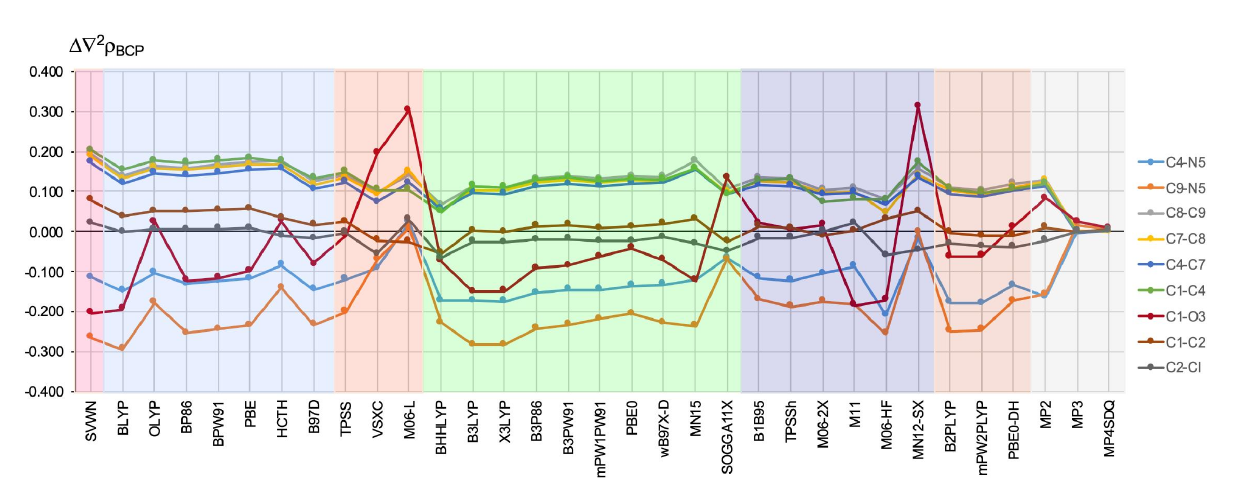
Figure 3. The difference (in relation to the CCSD method) in the value (in a.u.) of the Laplacian of the electron density determined at the bond critical point of the bond shown on the right side of the figure. The different types of methods are represented by a colored background: LDA—pink, GGA—blue, M-GGA—orangeish, H-GGA—green, HM-GGA—violet, DH-GGA—beige, perturba- tional